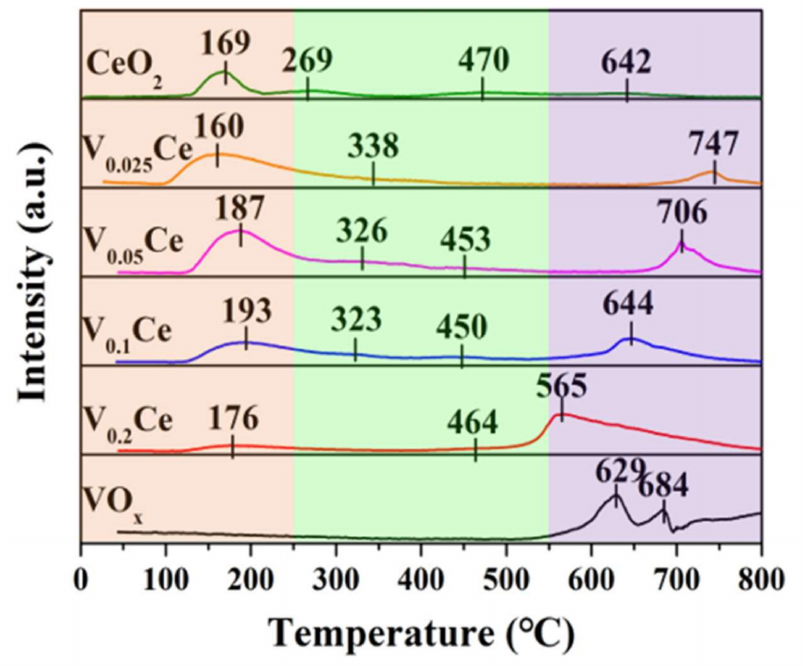
Figure 6. Temperature programmed desorption of O 2 (O 2 –TPD) profiles of prepared